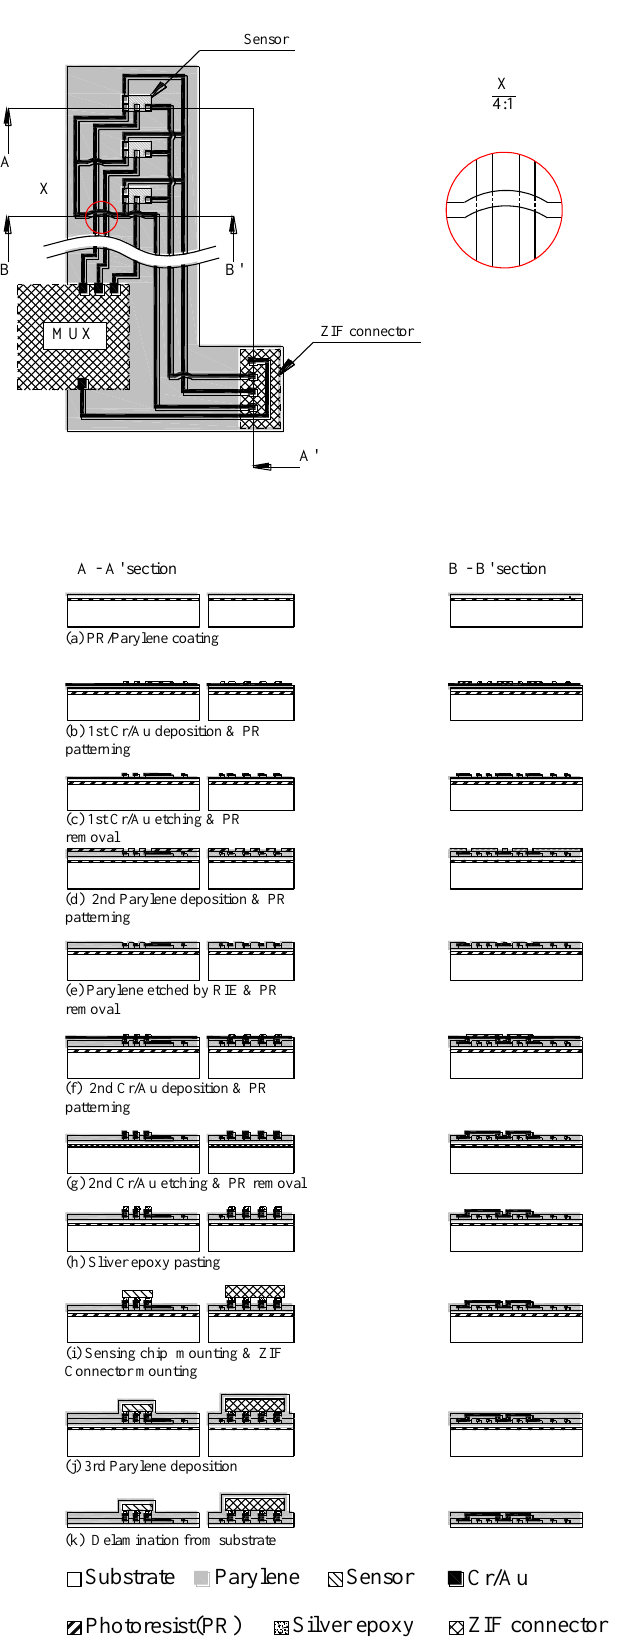
Figure 11. The fabrication process of the biocompatible flexible blood circuit